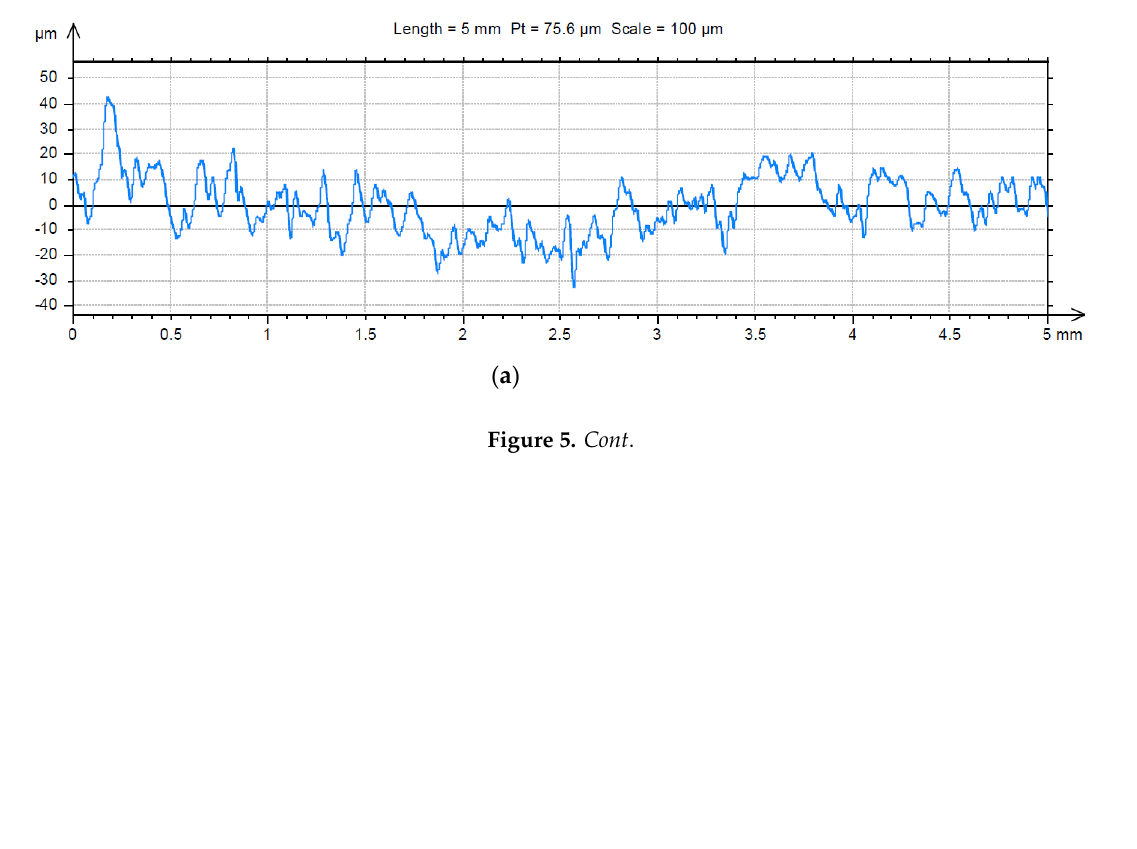
Figure 4. The surface of the reference material (galvanized steel) ( a ) and material covered with biofilm ( b ).